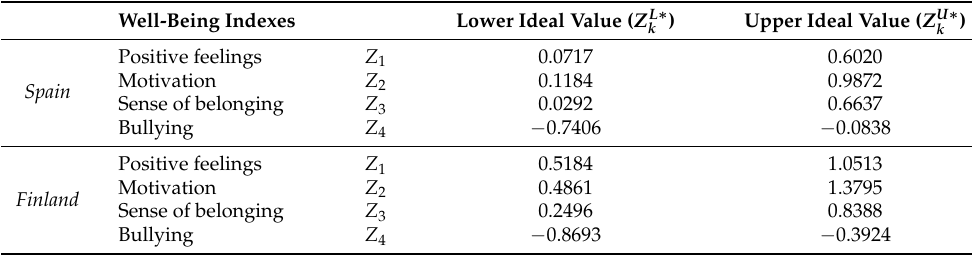
Table 7. Interval ideal values of each objective function in models (3) and (4).